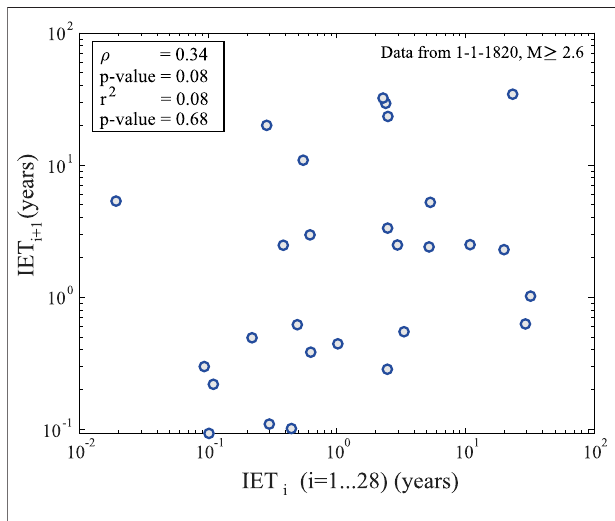
FIGURE 4 | Independence of pairs of successive